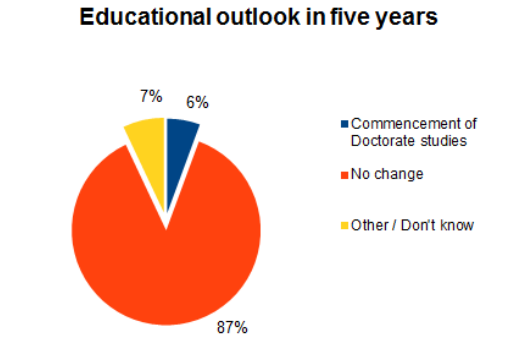
Figure 34 - Educational aspirations in the field of archaeology in five